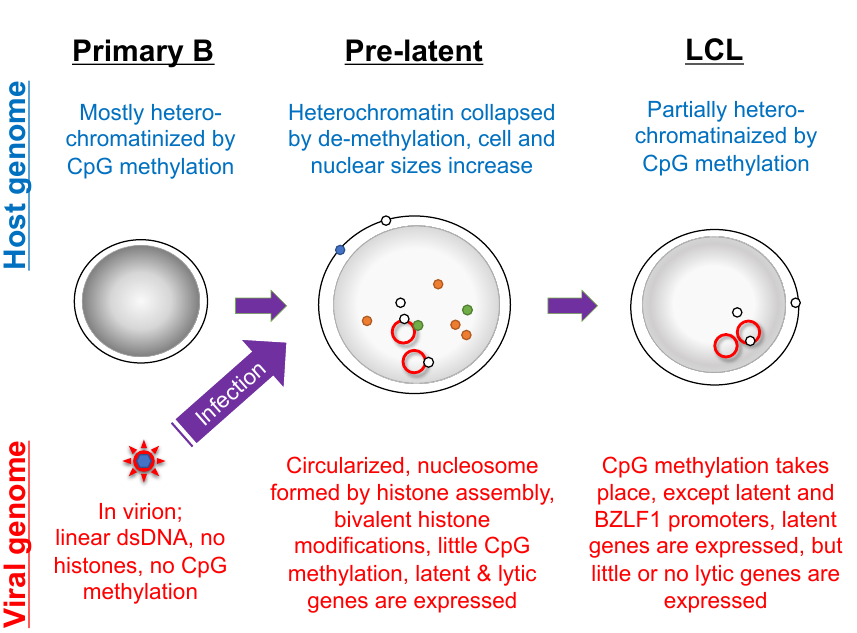
Figure 5. Morphology and epigenetic state of primary B cells infected with EBV. The EBV genome in virions is devoid of nucleosome structure and CpG DNA methylation, but is modified by histones and CpG methylation in infected cells. The host cell morphology and genome are significantly influenced by EBV infection. The red line indicates latent viral genome. Dark gray shadows in nuclei indicate strong heterochromatinization. Green, orange, and blue circles represent viral lytic gene products, and white circles represent viral latent gene